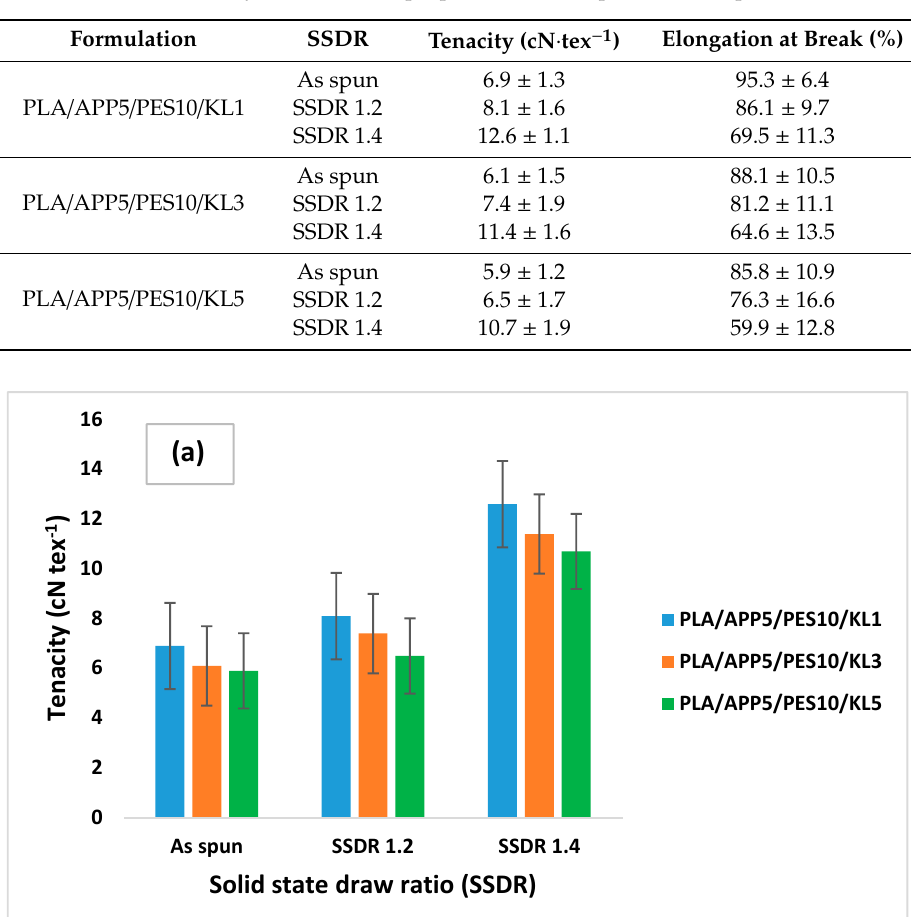
Table 5. Summary of mechanical properties of bicomponent melt-spun fibers.